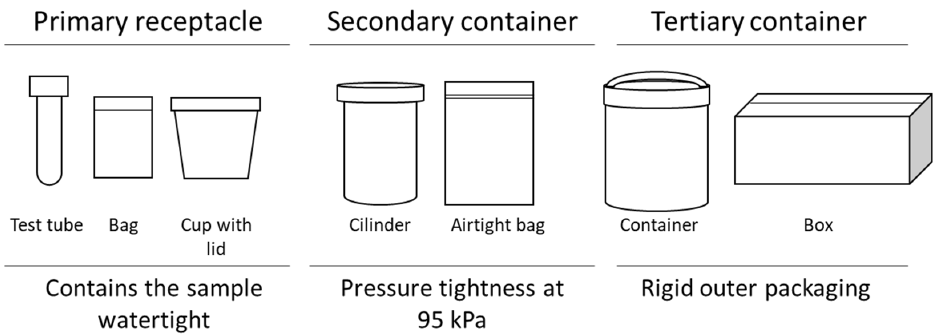
Figure 1. Category A infectious specimen packaging as per P620 from the ADR